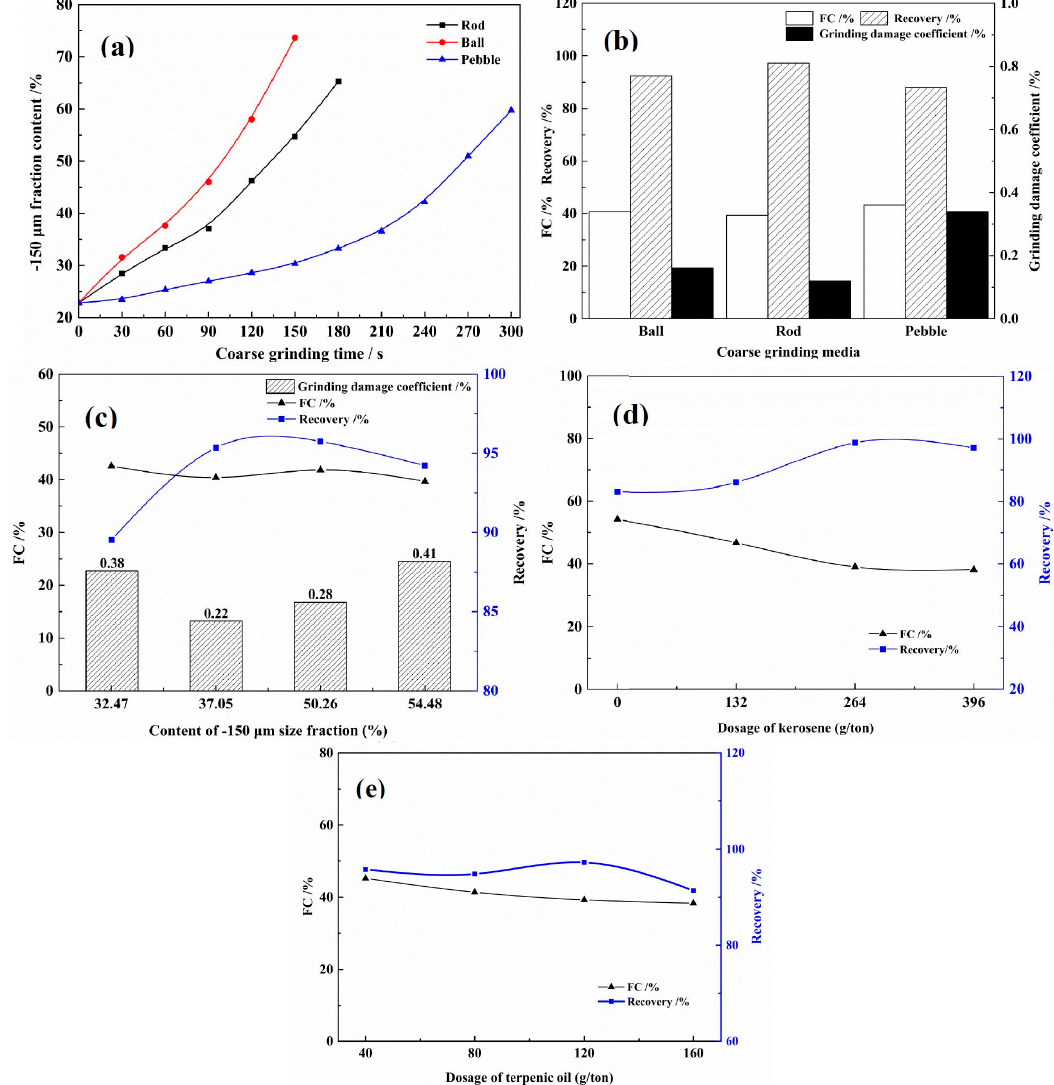
Figure 4. Experimental parameters of coarse grinding and rough flotation tests: ( a ) Grinding curves; ( b ) grinding media; ( c ) grinding fineness; ( d ) dosage of kerosene; ( e ) terpenic oil.